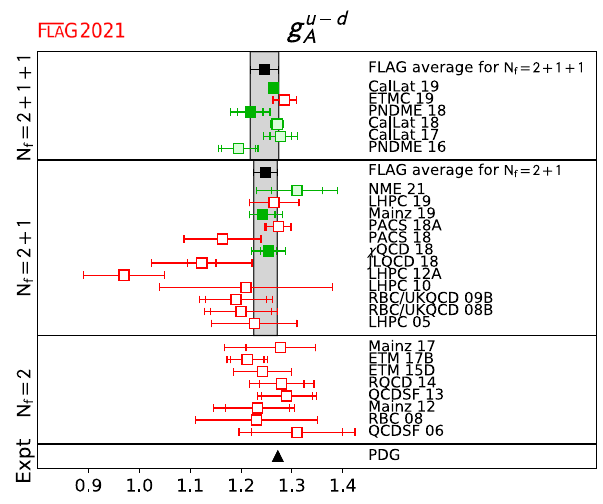
Fig. 43 Lattice results and FLAG averages for the isovector axial charge g u − d